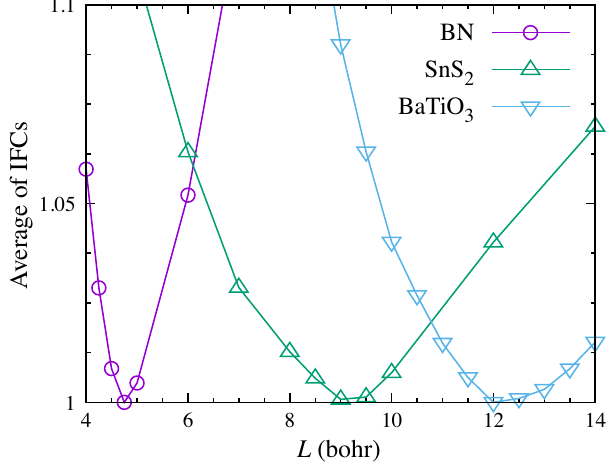
FIG. 4. Average of short-range IFCs (absolute value excluding self-interactions) as a function of the L parameter used to generate the long-range dynamical matrices. For each of the three materials studied in this work, the y -axis data are scaled by the minimum calculated